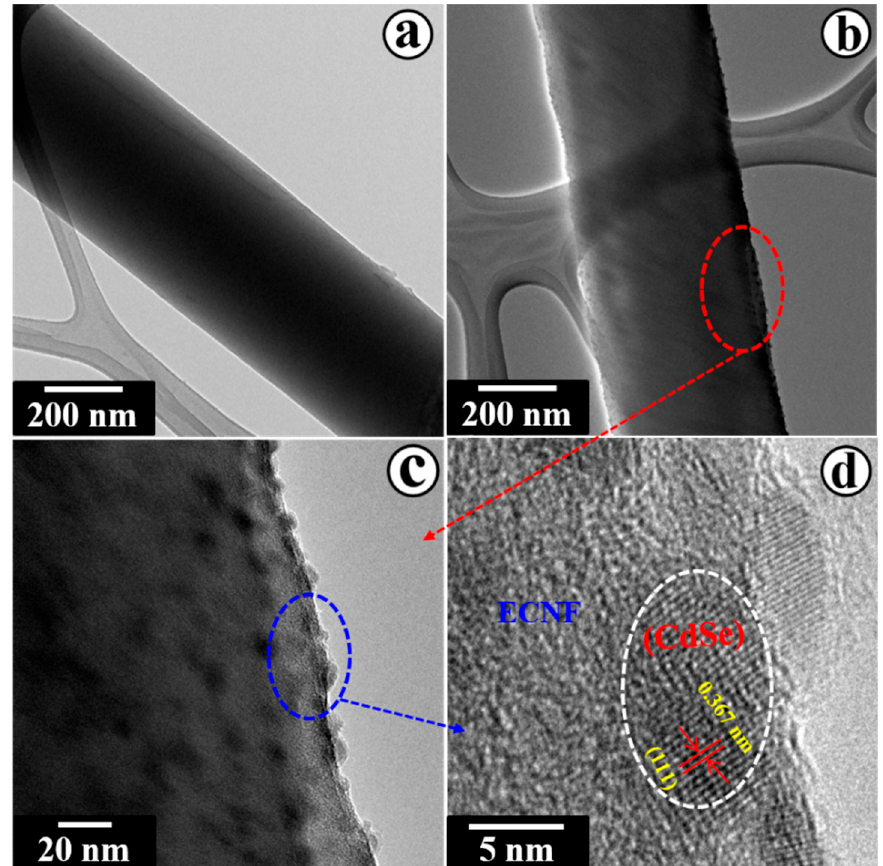
Figure 4. TEM images: ( a ) CNF, ( b ) Co-CdSe@ECNF, ( c ) magnified TEM image from the red circled area of (b), and ( d ) HR-TEM image from the blue circled area of (c).